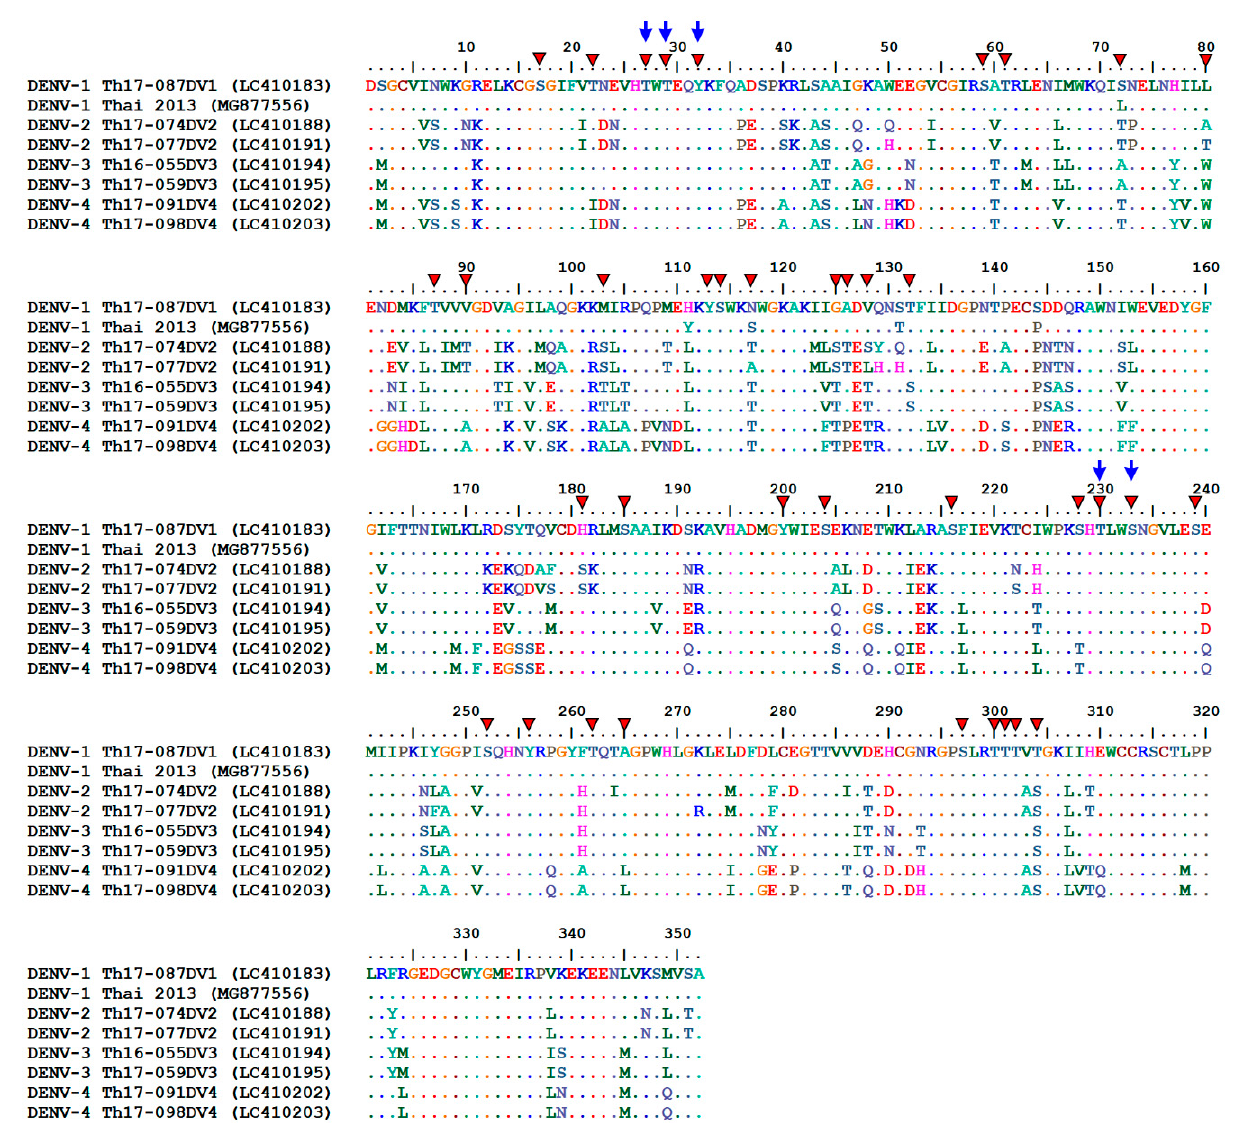
Figure 2. Amino acid sequence alignment of DENV NS1 proteins. Amino acid sequences of DENV NS1 were retrieved from the Virus Pathogen Database and Analysis Resource (ViPR) for dengue virus, which includes data specific to dengue virus isolation from humans in Thailand during 2000–2020. A total of 638 sequences of DENV NS1 (i.e., 330, 83, 105, and 120 sequences for virus serotypes 1, 2, 3, and 4, respectively) were obtained from the database and subjected to amino acid sequence alignment using BioEdit software version 7.2.5. The results show the alignment of two representative sequences of DENV NS1 (352 amino acid residues) from each serotype. Dots represent similar identity of amino acids at different positions on the NS1 protein. Potential phosphorylation sites at specific amino acid residues of DENV NS1, which were identified by LC-MS/MS, are shown in red triangles. Five amino acid positions on the DENV NS1 proteins with high frequency of detection of phosphorylated ions are indicated by blue arrows.